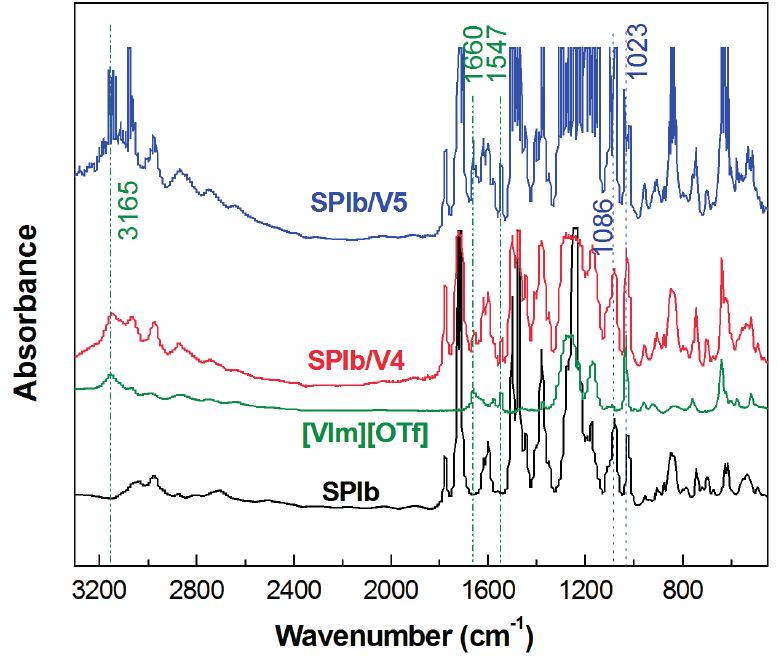
Figure 3. FTIR spectra of SPIb, [VIm][OTf] and SPI/IL composite